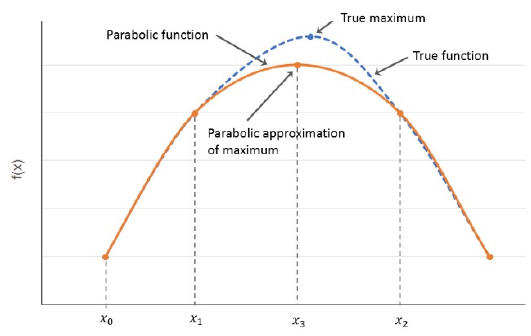
Figure 5. Quadratic approximation of a function